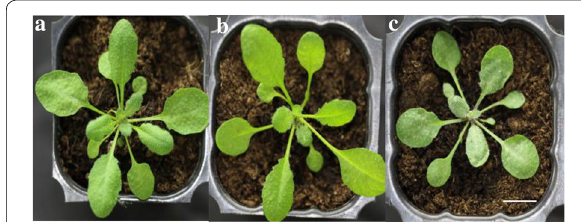
Fig. 1 Image of seedlings 25 days old. a Col‑0, b Atofp8 ‑ 1 , c 35S:HA ‑ AtOFP8 . Bar 1 cm =